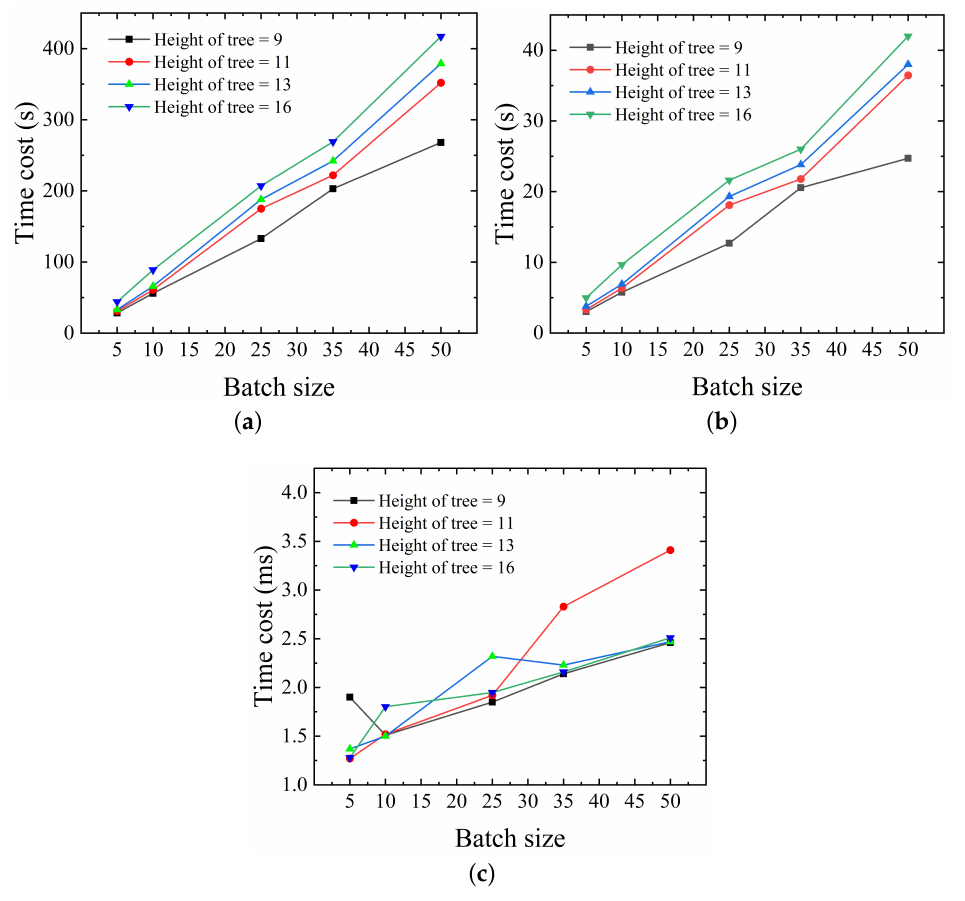
Figure 6. Time cost of functions related to ZK proof. ( a ) Time cost (s) of KeyGen . ( b ) Time cost (s) of Prove . ( c ) Time cost (ms) of Verify .